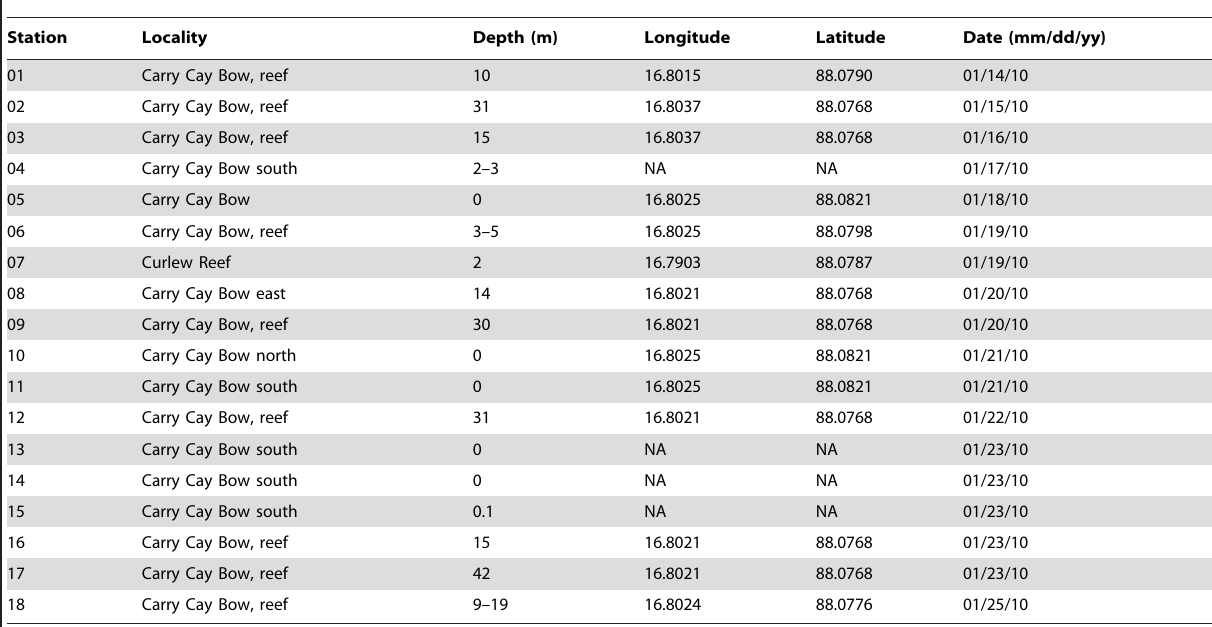
Table 1. Field stations at Belize where specimens of Nemertea were found.